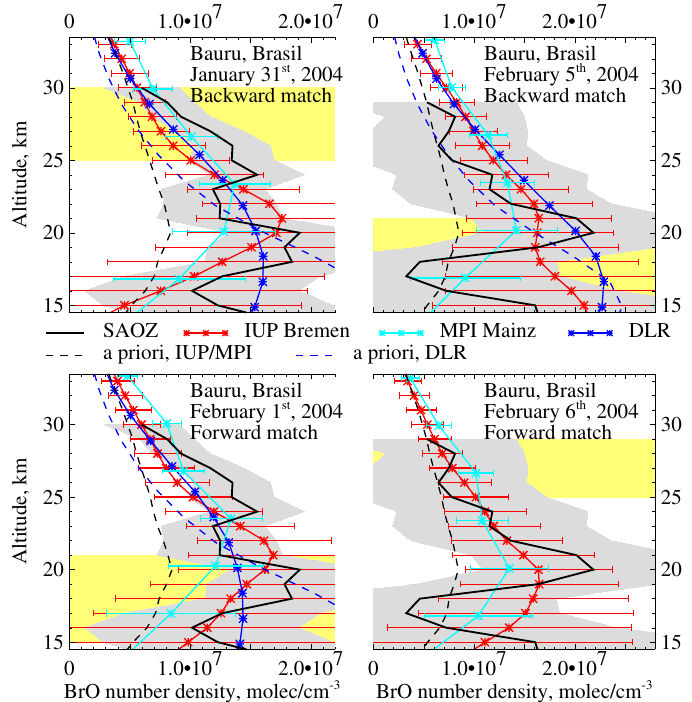
Fig. 27. Comparison of BrO vertical distributions retrieved from SCIAMACHY limb measurements using different retrieval algorithms to coinciding balloon-borne SAOZ observations. All balloon launches are in Bauru (tropics). Left panels: 31 January 2004. Right panels: 5 February 2004. Gray shadings depict the uncertainties of SAOZ results (1- σ ). Yellow areas mark vertical ranges where according to trajectory model calculations both instruments probe the same air